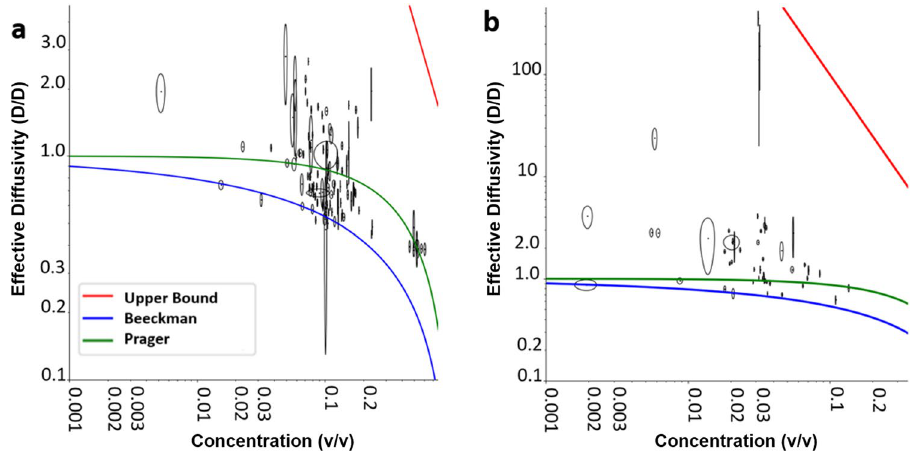
Figure 2. The measured hydrogen diffusivities compared to the two tortuosity models and the upper bound model (see text for details). Panel ( a ) shows the results for magnesium hydroxide. Panel ( b ) shows the results for alumina. The blue curves in panels ( a ) and ( b ) correspond to the Beeckman’s tortuosity model 39 . The green curve is the Prager upper limit model 40 . The red curves in panels ( a ) and ( b ) indicate the upper bound model, described by equation 1. Figure made with plots plotted with matplotlib 55 .